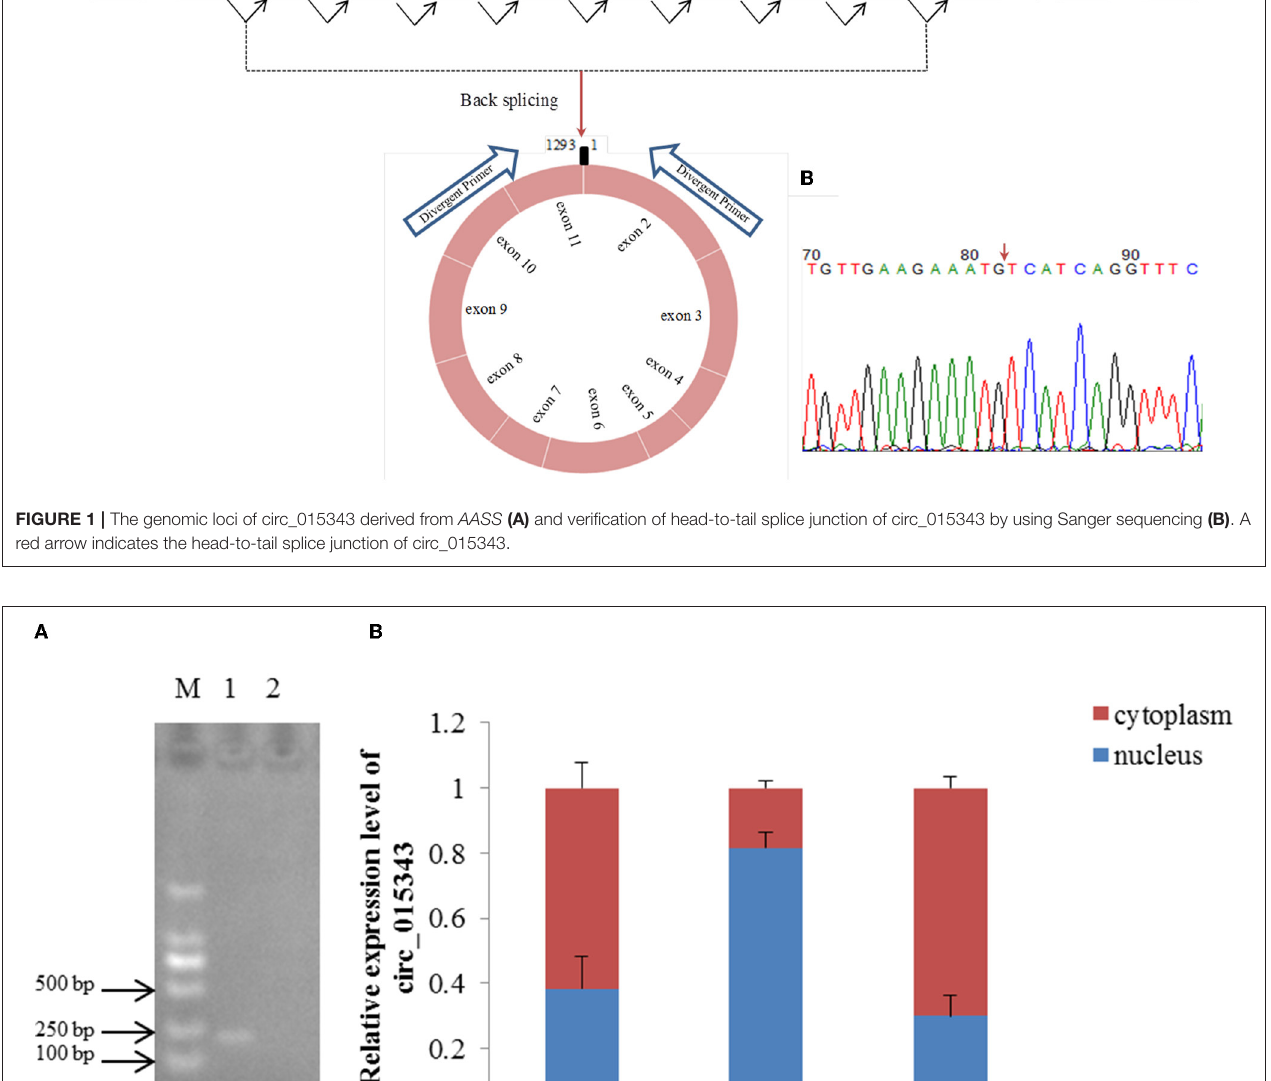
and the percentage of the circRNA in ovine mammary epithelial cells was accordingly calculated. The result showed that 62% of circ_015343 is located in the cytoplasm, while 38% is expressed in the nucleus ( Figure 2B